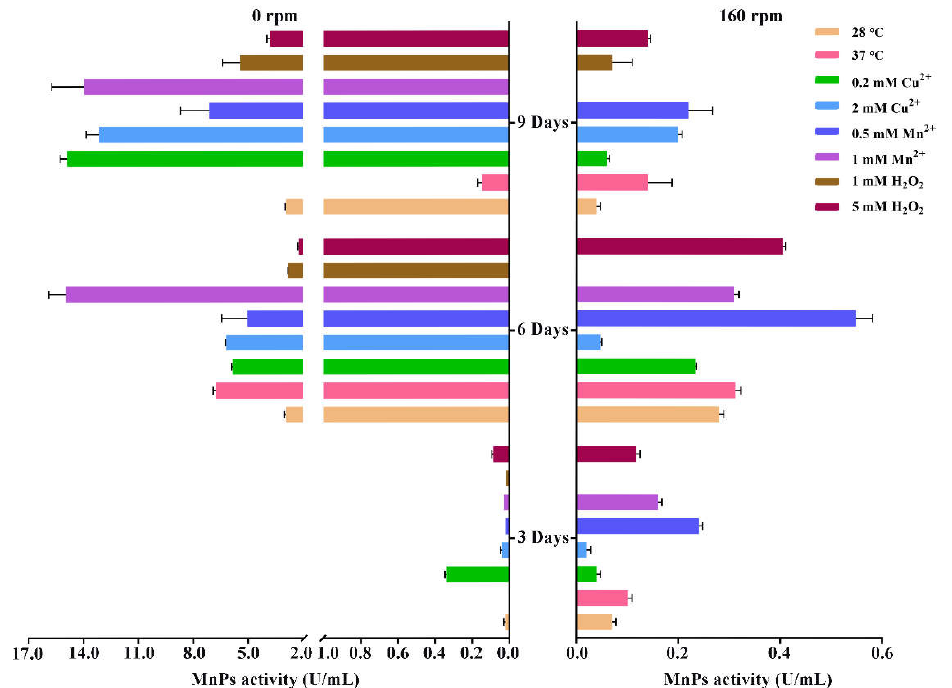
Figure 5. MnP production by T. trogii S0301 treated with Cu 2+ , Mn 2+ , and H 2 O 2 and temperatures under static ( Left ) and shake ( Right ) liquid culture.